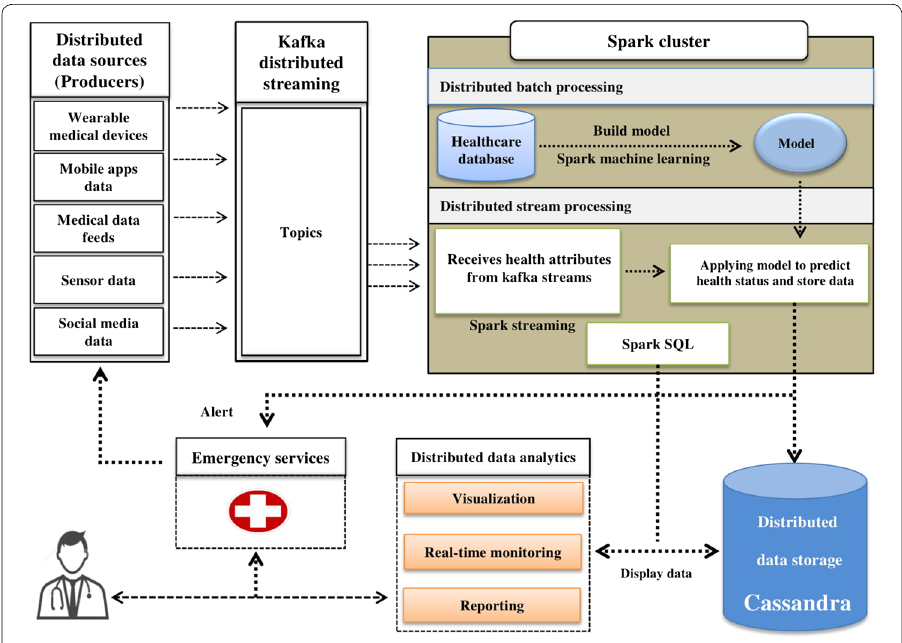
Fig. 2 Architecture of real‑time health status prediction and analytics